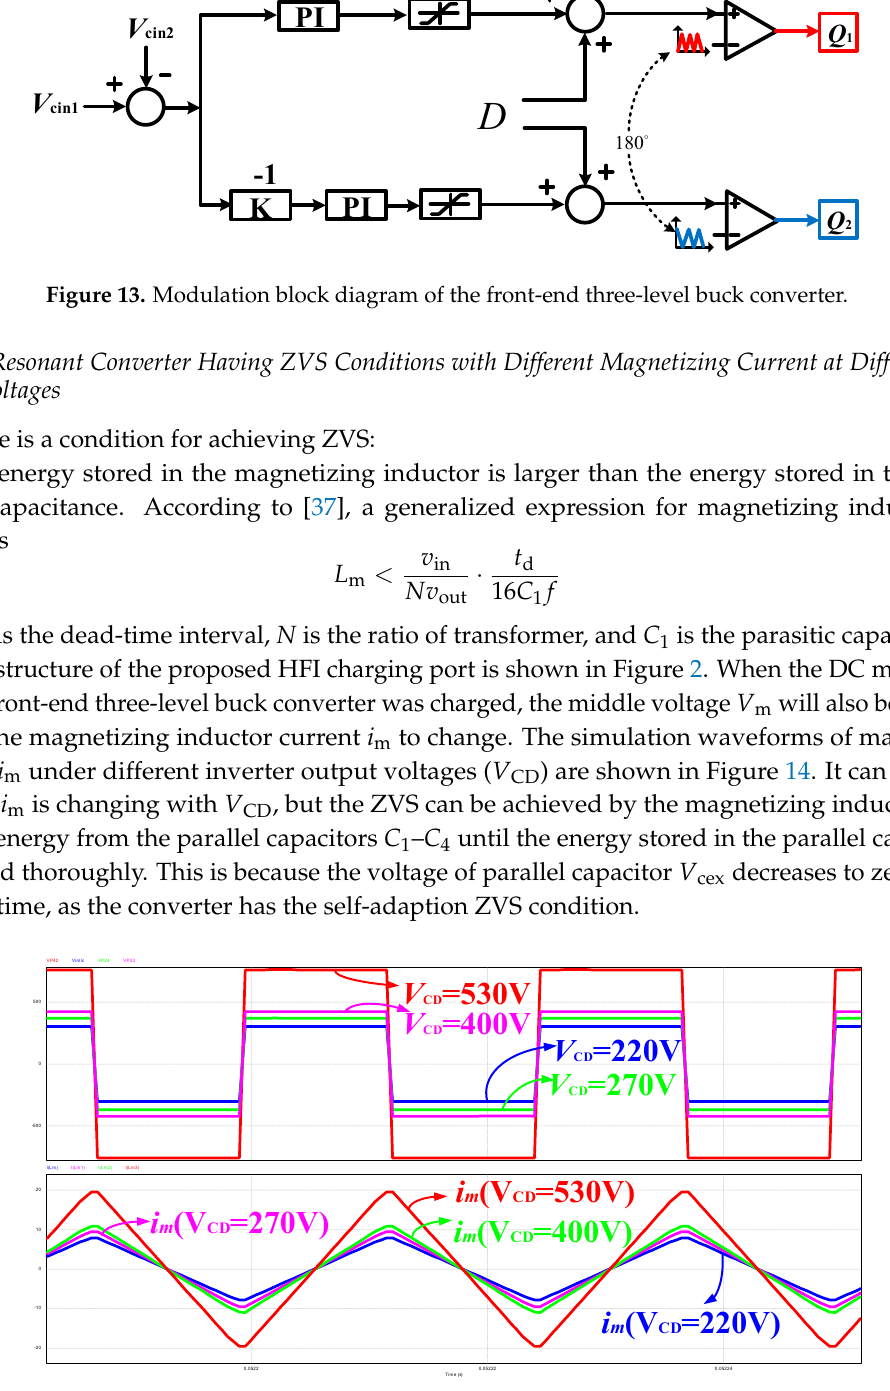
Figure 14. Simulation waveform of magnetizing inductor current under different V CD values.